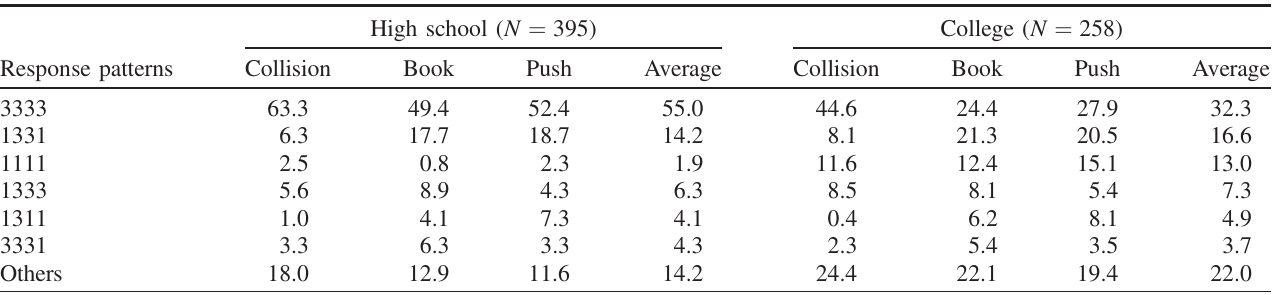
TABLE III. Percentage ranking of students ’ 4-question response patterns on the four attributes of causal reasoning in different scenario contexts. The patterns are ordered based on their popularity among college students. High school ( N ¼ 395